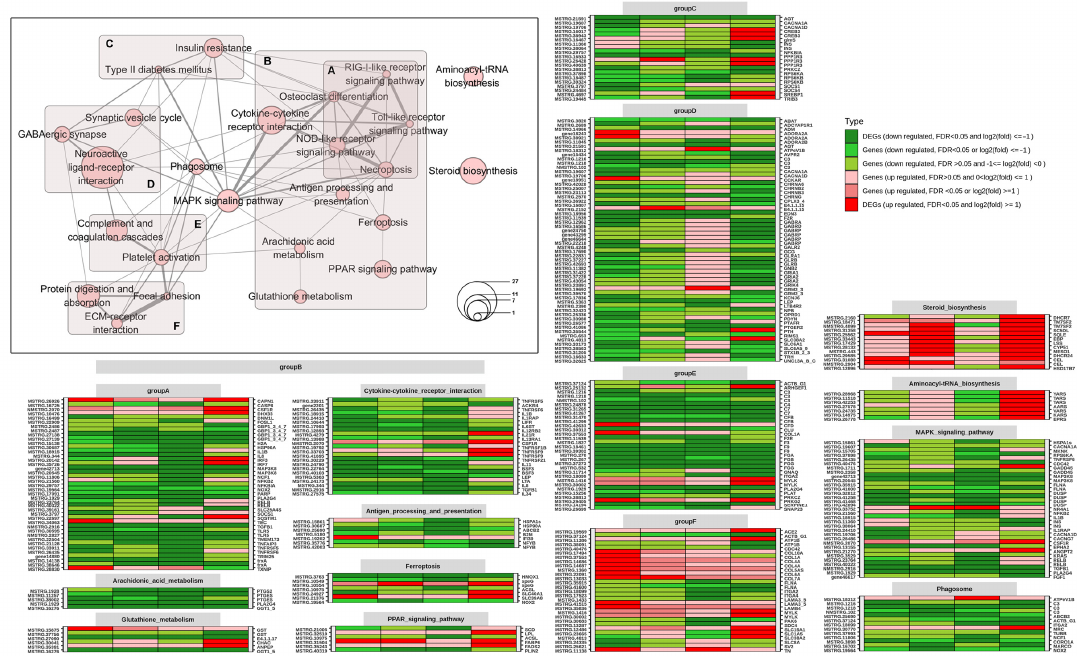
Figure 3. The network of enriched pathways and heat maps of DEGs. The order of four viruses in all the heat maps is CaHV, CyHV2, GCRV, and